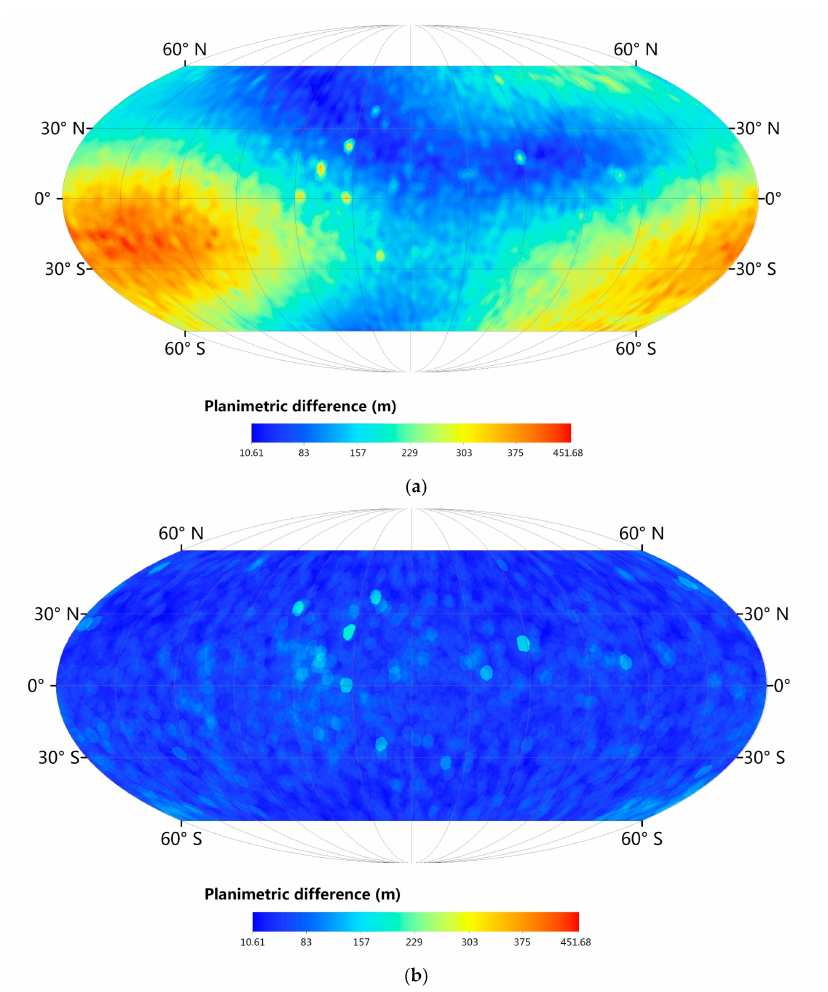
Figure 8. Color-coded map of planimetric difference at a 1 ◦ grid space between ( a ) SLDEM2015 and CE2TMap2015_DEM_20m before registration; ( b ) SLDEM2015 and CE2TMap2015_DEM_20m after